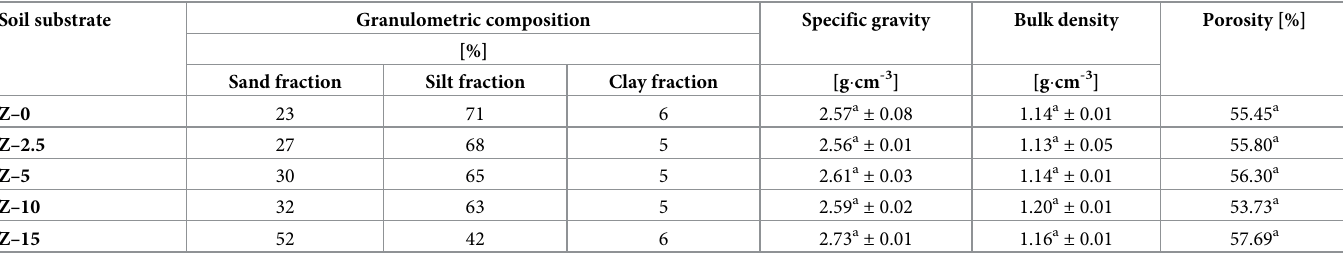
Table 3. Physical properties of the soil and the mixtures (average value ± standard deviation).